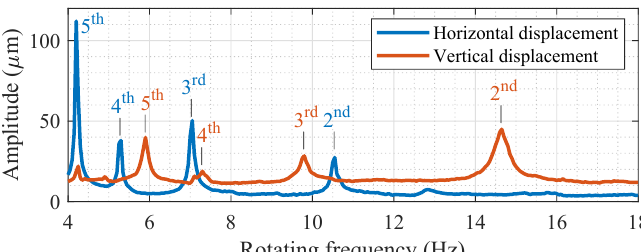
Figure 3. Response measurement of the test rotor. The results are separated to horizontal and vertical